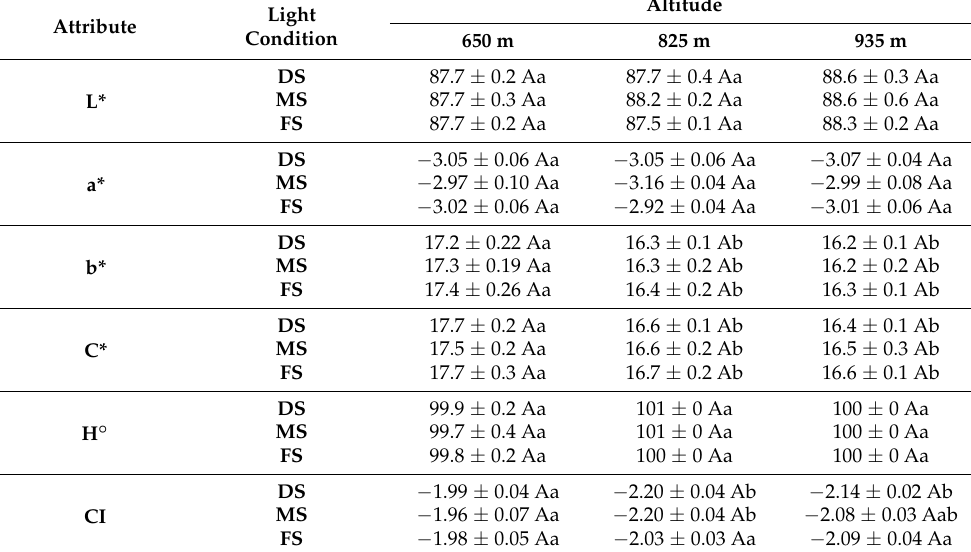
Mean values ± SE (n = 5) followed by the same letter, comparing light conditions within each altitude (A, B) or altitude treatments within each light condition (a, b), are not significantly different according to the Tukey’s HSD for mean comparison ( p < 0.05), always separately for each